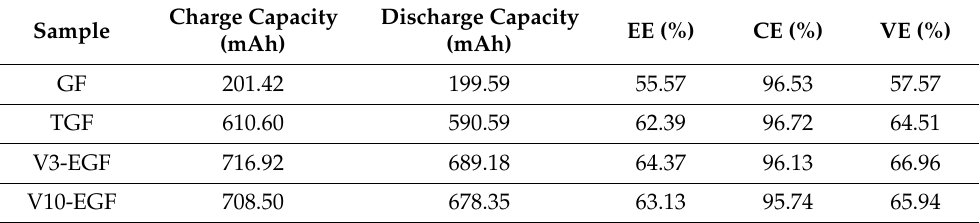
Table 3. Capacity and efficiency values of GF electrode at current density of 150 mA cm − 2